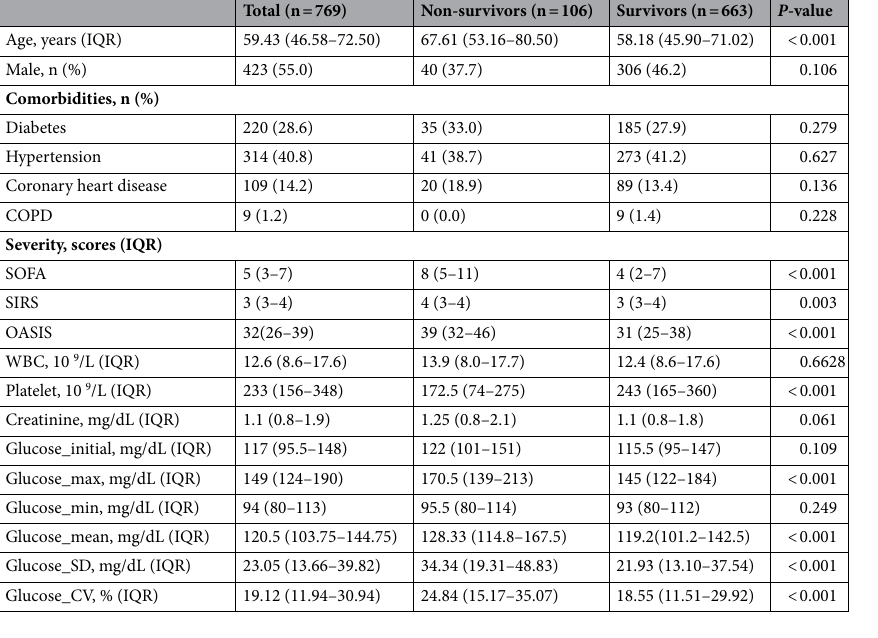
Table 1. Characteristics of patients with acute pancreatitis. IQR interquartile range, COPD chronic obstructive pulmonary disease, SOFA sequential organ failure assessment, SIRS systemic inflammatory response syndrome, OASIS Oxford acute severity of illness score, WBC white blood cell, SD standard deviation, CV coefficient of variation.